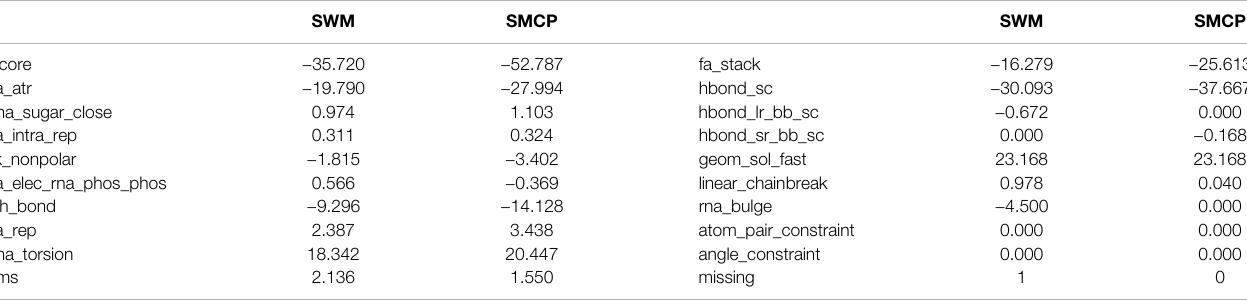
TABLE 3 | Comparing the results of SWM and